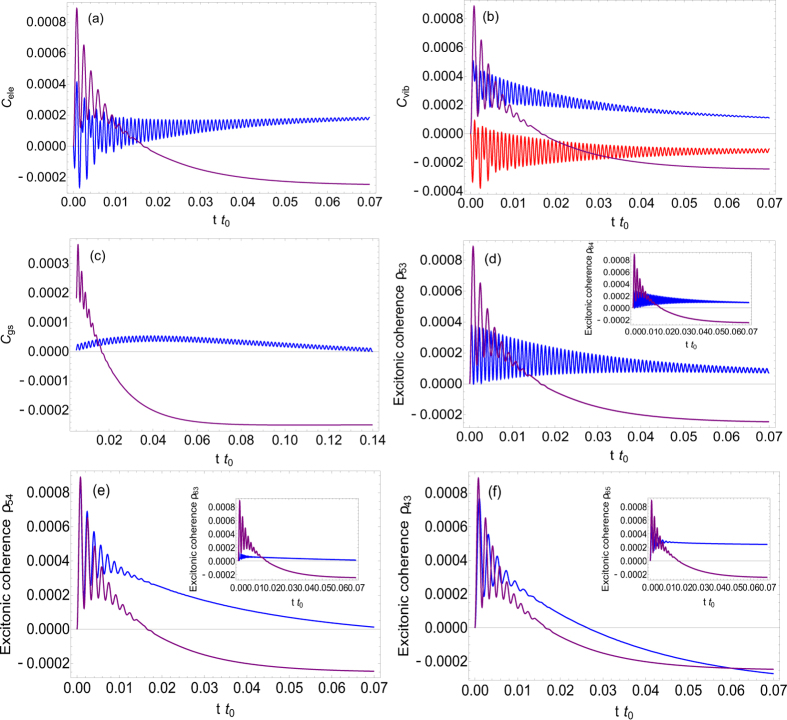
Top: Time evolution of (a) electronic wave packet, (b) excited-state vibrational wave packet and (c) ground-state vibrational wave packet. In (a,c), blue lines are for our model in non-adiabtic regime; In (b) the blue and red lines correspond to excited-state vibrational wave packets 〈A, 0|ρ|A, 1〉 and 〈B, 0|ρ|B, 1〉, respectively. Bottom: Time evolution of the excitonic coherence in delocalized basis, where blue lines correspond to non-adiabatic regime. Purple lines in (a,b,c) electronic and (d,e,f) excitonic coherences are for adiabatic regime, respectively. The parameters are: Frank-Condon factor , Δ = 0.023εA, electronic coupling J = 0.01εA, frequency of vibrational mode ħω = 1.33Δ, kBT1 = 0.63εA, kBT2 = 1.4Δ, Debye frequency ħωd = 0.7Δ, typical decay rate hγ = 0.0005εA, reorganization energy ER = 0.23Δ and t0 = 10γ−1.